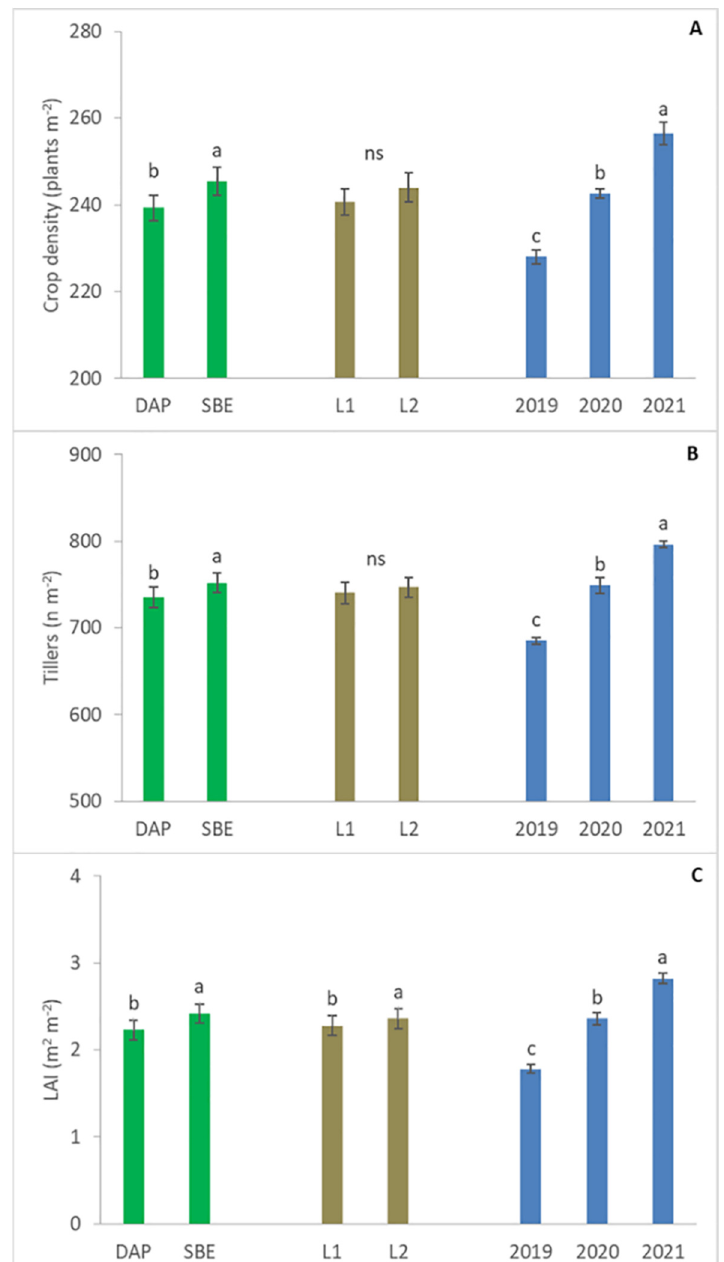
Figure 1. Crop density ( A ), tiller density ( B ), and LAI ( C ) for each applied fertilizer, location, and growing season. Error bars represent the standard error of the means; letters above the histograms correspond to the ranking of the Fisher’s protected test at p < 0.05.